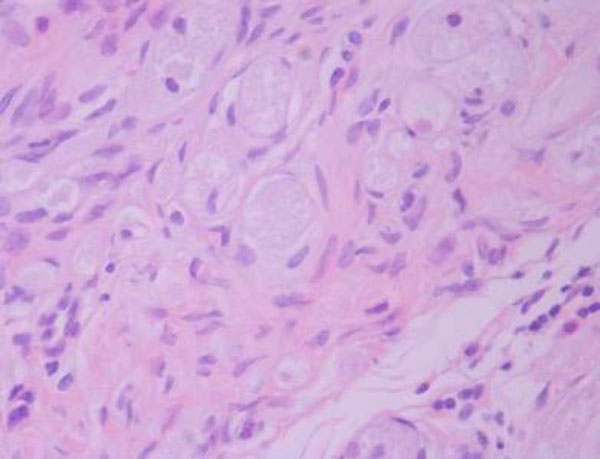
Histological section stained with hematoxylin & eosin (X 40).